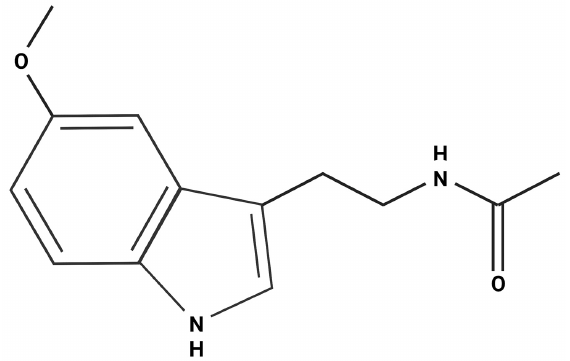
Figure 2. Biochemical structure of melatonin ( N -acetyl-5-methoxytryptamine). Melatonin is an ancient molecule associated with the phylogenetic development from unicellular organisms to multiorgan living systems without any structural modification over millions of years [107]. Primitive photosynthetic bacteria, where melatonin probably evolved as a protection against oxidative stress, were theoretically phagocytized by early eukaryotes and developed into mitochondria and chloroplasts. During evolution, via the distribution of mitochondria, melatonin was subsequently spread to all multicellular or- ganisms with new sites of generation and functional implications [103,107]. Although the melatonin synthetic pathway is slightly different in plants and animals, the stepwise en- zymatic conversion from the amino acid tryptophan to serotonin and melatonin repre- sents the principal metabolic route [107]. Melatonin is an unusually multitasking molecule that participates in an uncountable number of physiological and pathological actions [108–110]. Although the modulation of circadian rhythms is considered to be a principal role of melatonin, this indolamine exerts protection in various organs and systems. In the cardiovascular system, it participates in blood pressure (BP) regulation and BP decline during the night and exerts antifibrotic effects in the left ventricle [111,112]. Melatonin has also been shown to improve glucose and lipid metabolism, modulate body weight and energy metabolism, attenuate neuro- degenerative processes and depressive and anxiety behavior and expresses anticancer ac- tions [103,109,113]. This indolamine exerts its effects either via specific membrane recep- tors, cytoplasm or nucleus-bound proteins or via receptor-independent biological actions (Figure 3). Two types of melatonin-specific G-protein-coupled membrane-bound recep- tors were identified as MT1 and MT2 [114]. The action via the Gi protein is mediated by a reduction of cyclic adenosine monophosphate, with attenuation of protein kinase activity, and via the Gq protein that is followed by phospholipase and protein kinase C activation. The subsequent signaling may result in an increased level of intracellular calcium and nitric oxide (NO) formation [115]. Other melatonin-binding sites with obscure biological impacts involve MT3/quinone reductase (QR2) in membranes [116], nuclear retinoid or- phan receptors/Z receptors (RORs/RZRs) [117] and intracellular proteins, e.g., calmodulin or tubulin [118].